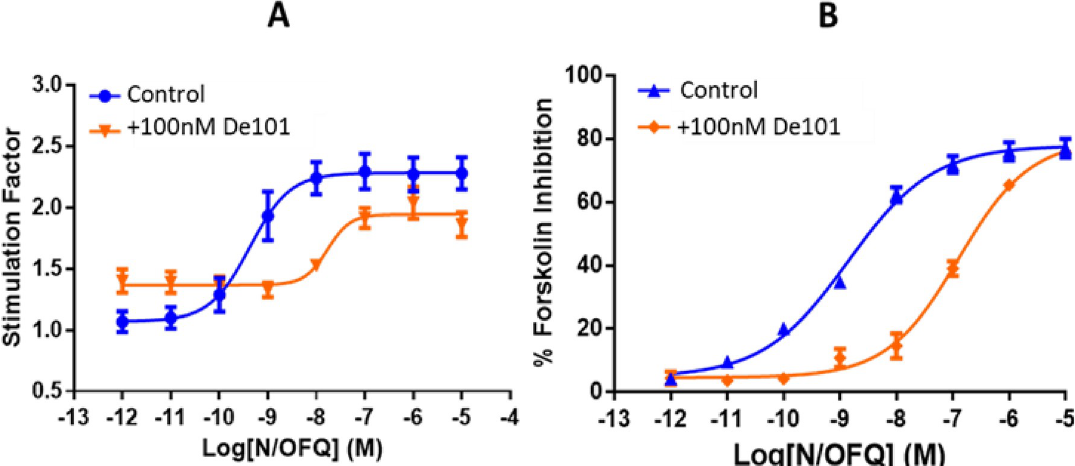
Fig 10. Demonstration of antagonist activity of De101 (100nM) against a range of concentrations of N/OFQ in (A) GTP γ [ 35 S] assays in CHO NOP and (B) in HEK NOP cells using a cyclic AMP assay. Data are the mean ( ± SEM) of n = 5